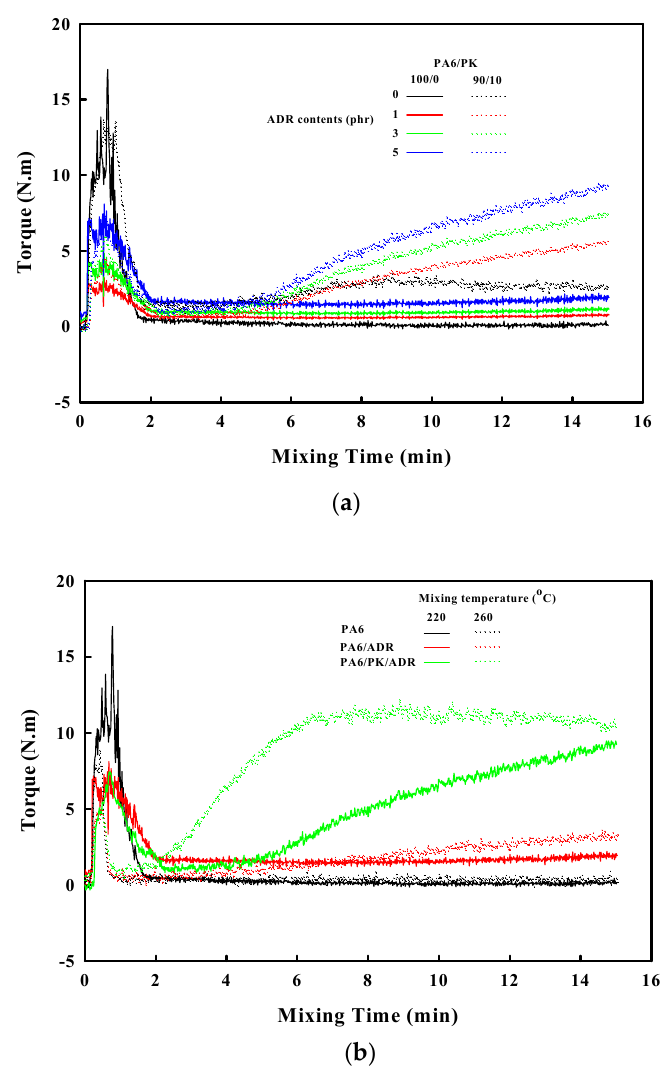
Figure 3. Effect of mixing time on the melt torque of PA an PA6/PK(90/10) blend ( a ) at different ADR contents and ( b ) processed at different mixing temperatures.